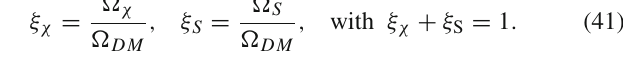
scalar DM is always heavier than fermionic DM, in